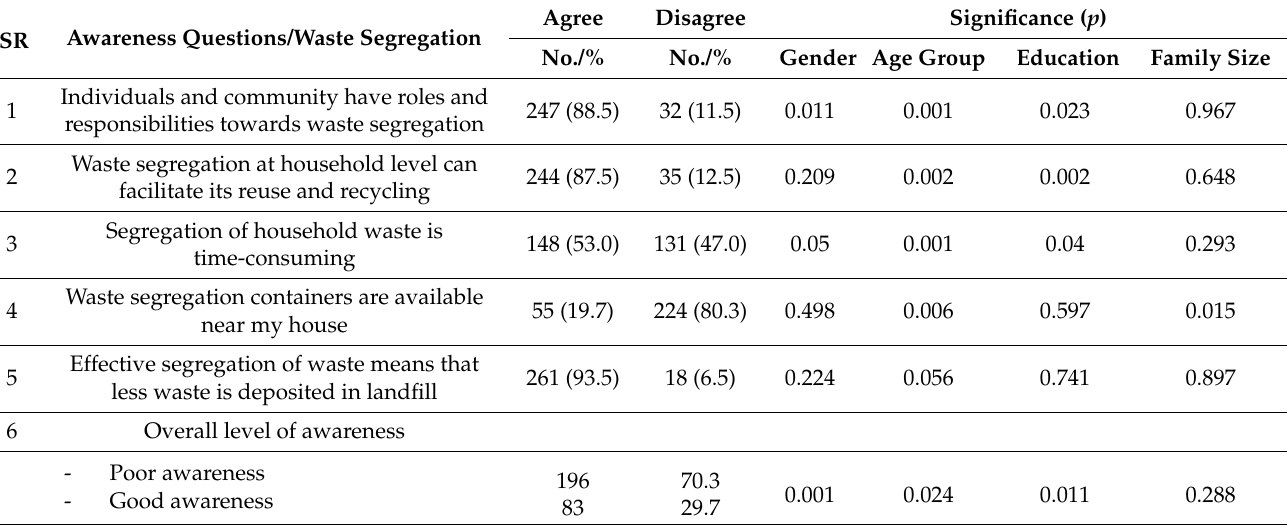
Table 4. Awareness of the households about waste segregation ( n =